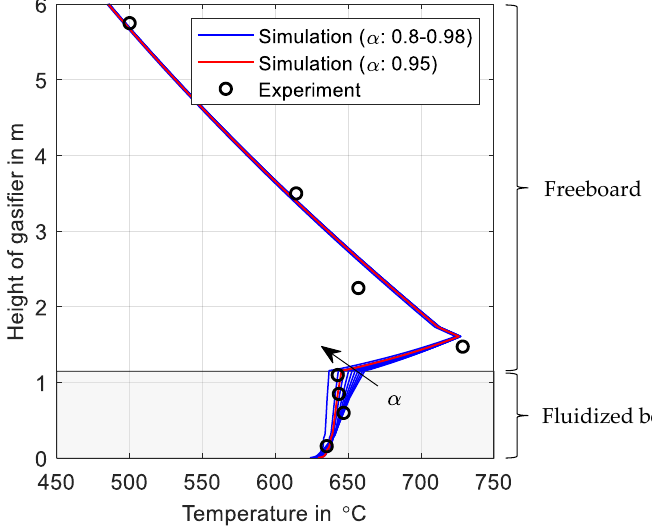
Figure 6. Simulated temperature profiles of the gasifier for various α (ranging from 0.8 to 0.98); 𝑀̇ BM , wf = 29.7 kg / h, S / C = 2.2 mol / mol, WHSV (weight hourly space velocity) = 0.68 1 / h, limestone make-up 6.6 kg / h, and comparison with experimental data from 200 kW dual fluidized bed (DFB) pilot plant [11].